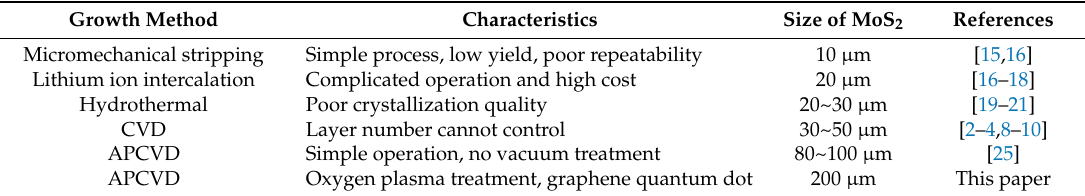
Table 1. Comparison of different growth modes of MoS 2